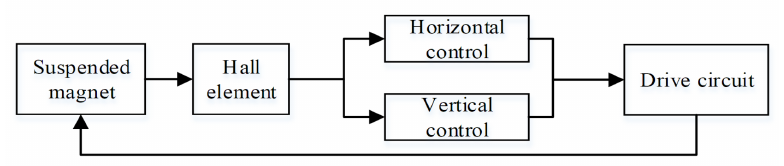
Figure 2. System control